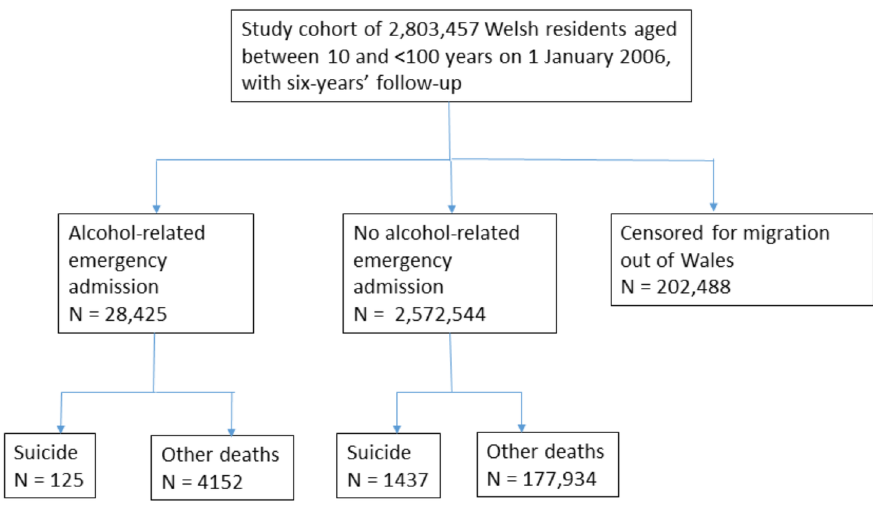
Fig 1. Study flow chart.